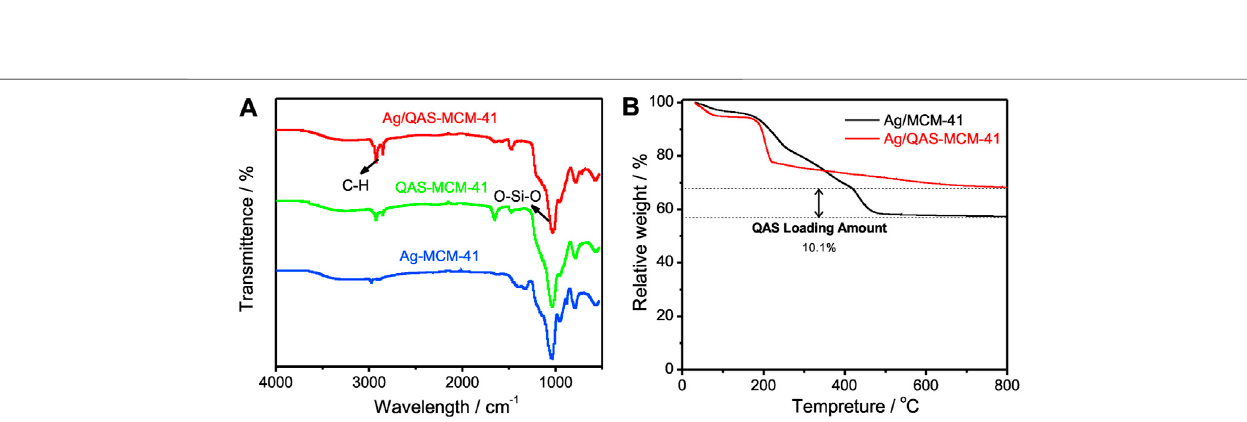
FIGURE 2 | (A) FIIR spectra of Ag/QAS-MSNs, QAS-MSNs, and Ag-MSNs. (B) Thermogravimetric analysis (TGA) curves of Ag/QAS-MSNs and